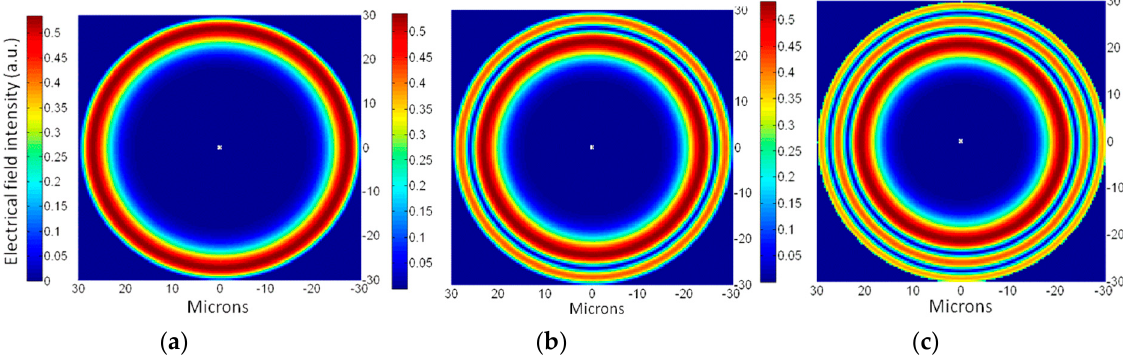
Figure 2. The electric field intensity distribution along the fiber radius for ( a ) p = 1, λ m ,1,0 = 1.4526 µ m, ( b ) p = 2, λ m ,2,0 = 1.3948 µ m, and ( c ) p = 3, λ m ,3,0 = 1.3597 µ m. r co = 30 µ m, m = 176.